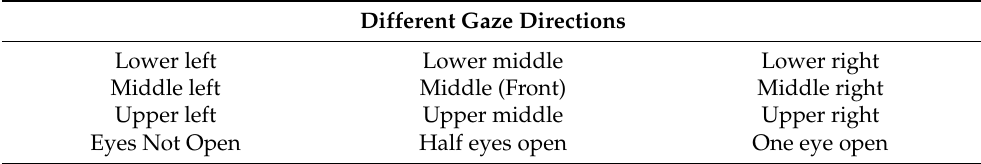
Table 3. Eye gaze directions estimated in proposed system.